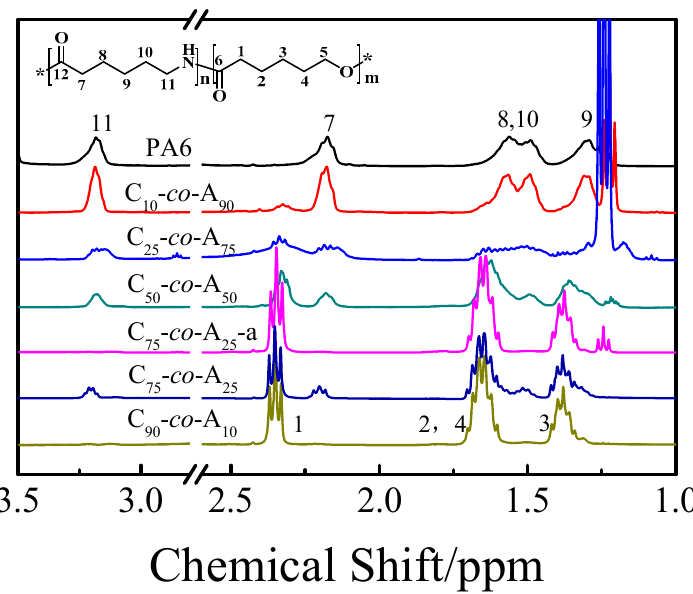
Figure 1. 1 H nuclear magnetic resonance (NMR) spectra of P(CLA- co -CLO) copolymers. (solvent: 50/50 (volume ratio) CDCl 3 /HFIP, 400MHz).